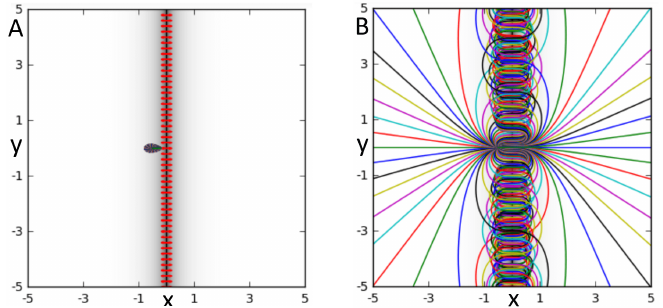
Figure 13: Null geodesic trajectories for the dreibein wall, with m ( x ) = tanh ( x ) . A: Geodesics launched near the wall of singularities. The singular manifold has been labeled with collimation arrows. B: The long-time geodesic dynamics. Note that some geodesics are in permanent bound states along the singular wall, while others escape to infinity. The separation between bound and free orbits is determined by Eq. (67). All crossings of the singular wall occur at the collimation angle θ ∗ = 0 (or π